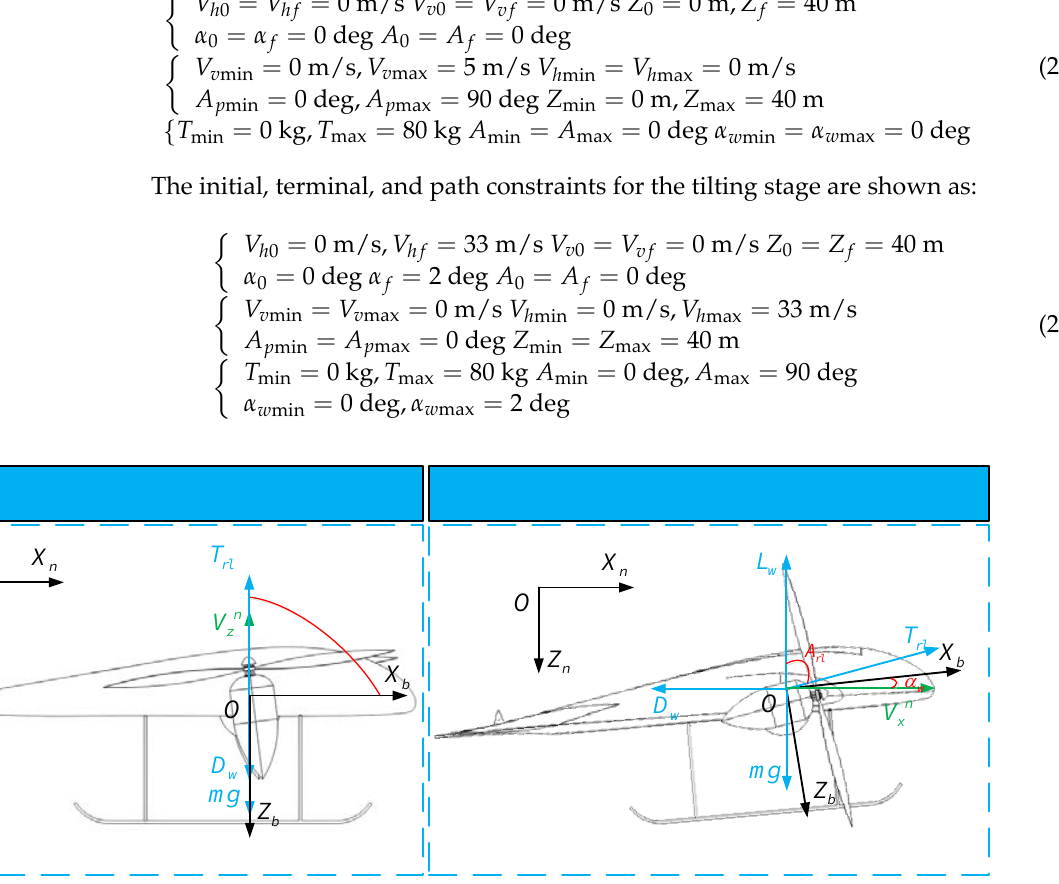
Figure 8. Force analysis in vertical and tilting stages of the VTO.